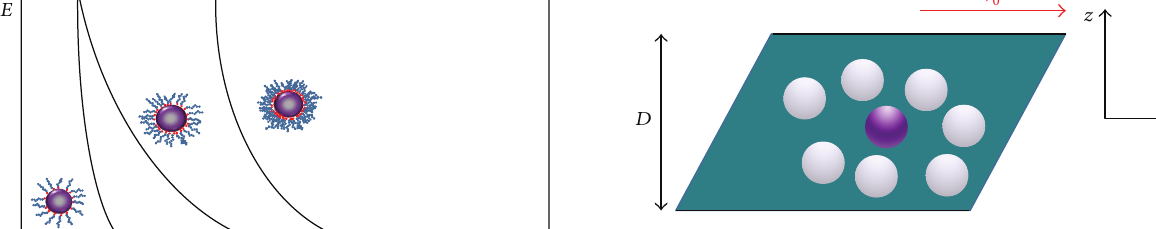
Figure 7: Deformation of a fluid element composed of colloidal particles (gray) suspended in a continuous medium (green). The fluid element is being deformed by an external force, which estab- lishes a steady flow with velocity V 0 between two separated surfaces by a distance 𝐷 . The particle’s dynamics, in purple, is affected by collisions with its neighboring